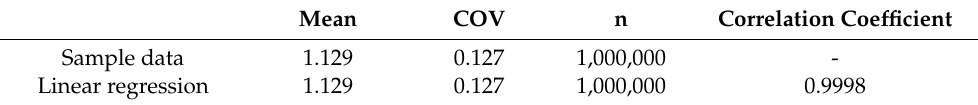
Figure 8. Plot of the simulated shear resistances on a normal PDF paper. Table 21. Probabilistic characteristics of the shear resistance from Monte-Carlo simulation.